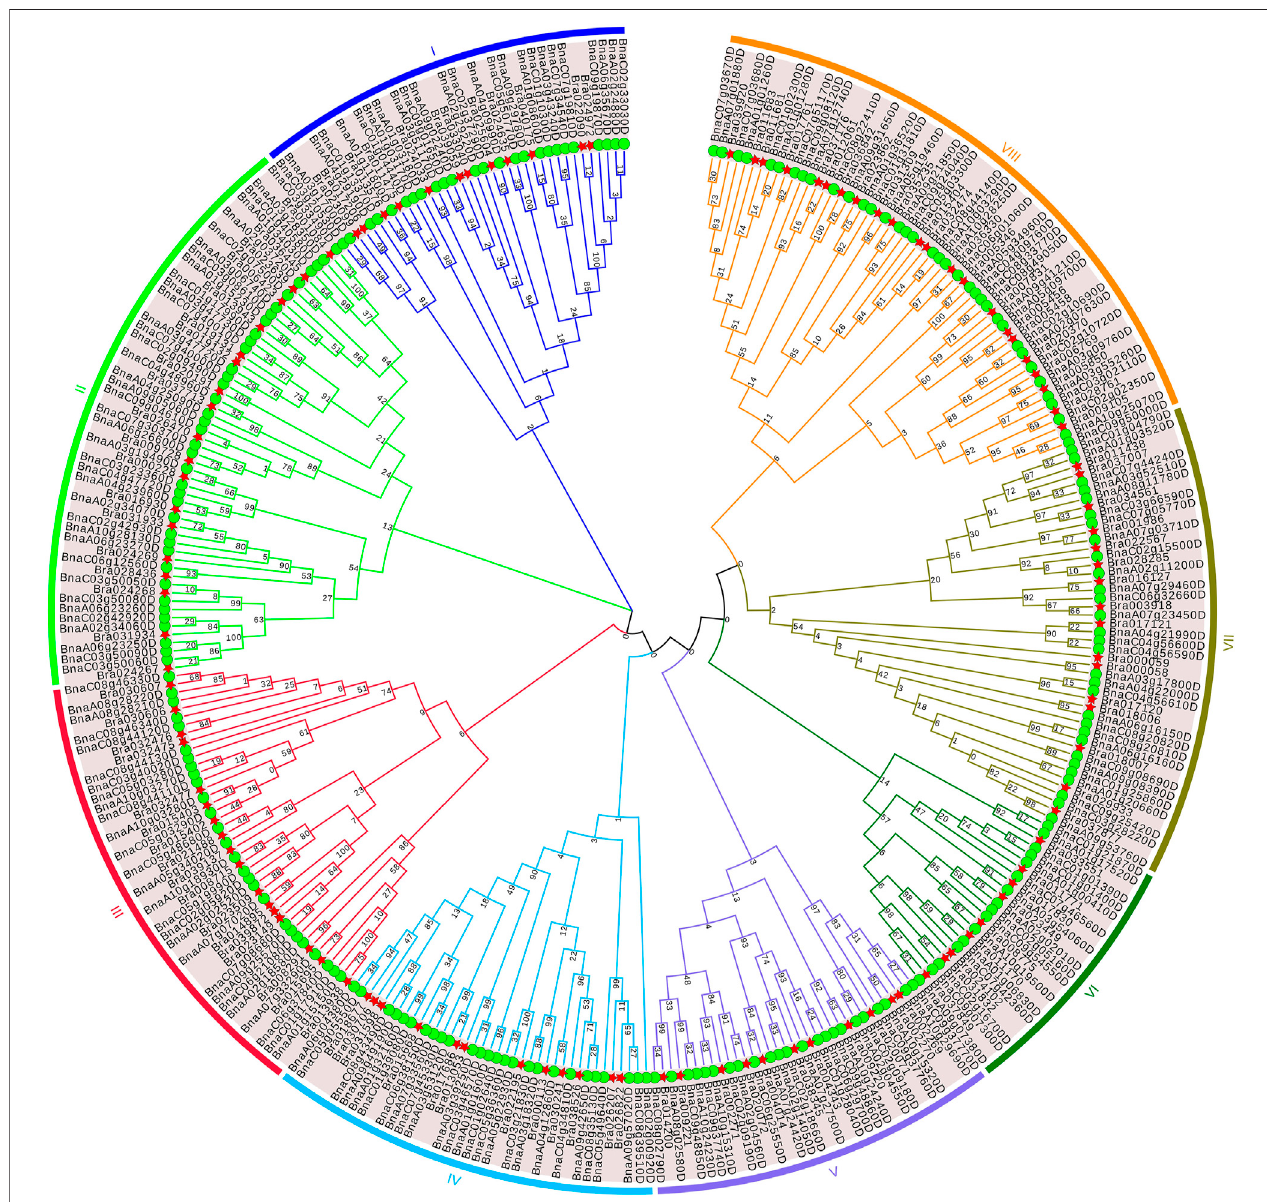
FIGURE 2 | Phylogenetic tree of APX protein of B.napus and B.rapa . Eight subfamilies and branches are marked with different colors. Green circles represent B.napus , and red stars represent B.rapa .